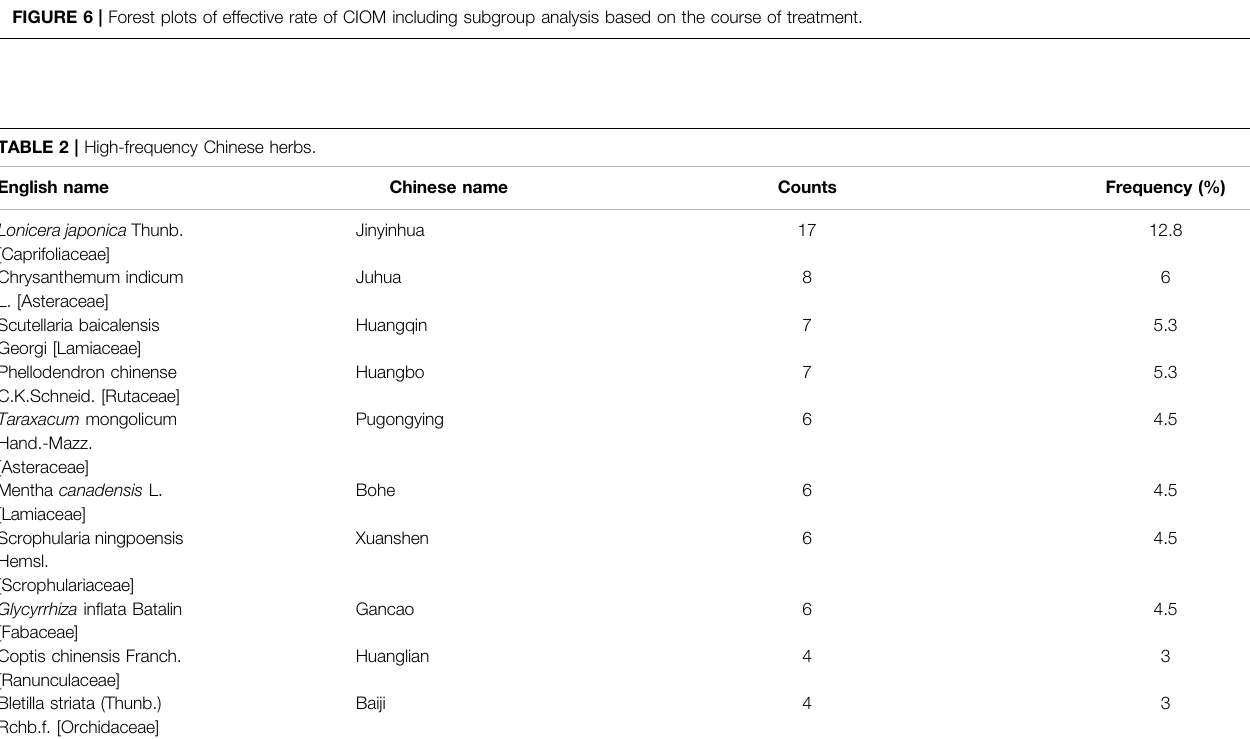
Effect on Oral Pain Four trials reported patients ’ pain scores on a numeric rating scale. Among them, three trials (Wang et al., 2011; Zhang, 2015;